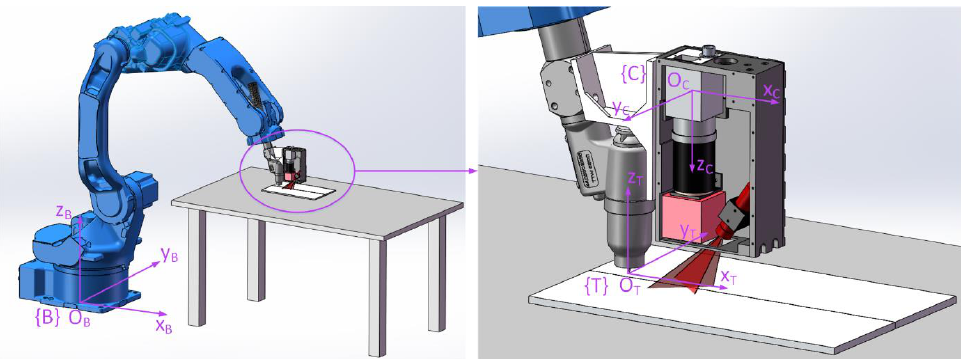
Figure 11. Coordinate systems involved in the coordinate transformation.